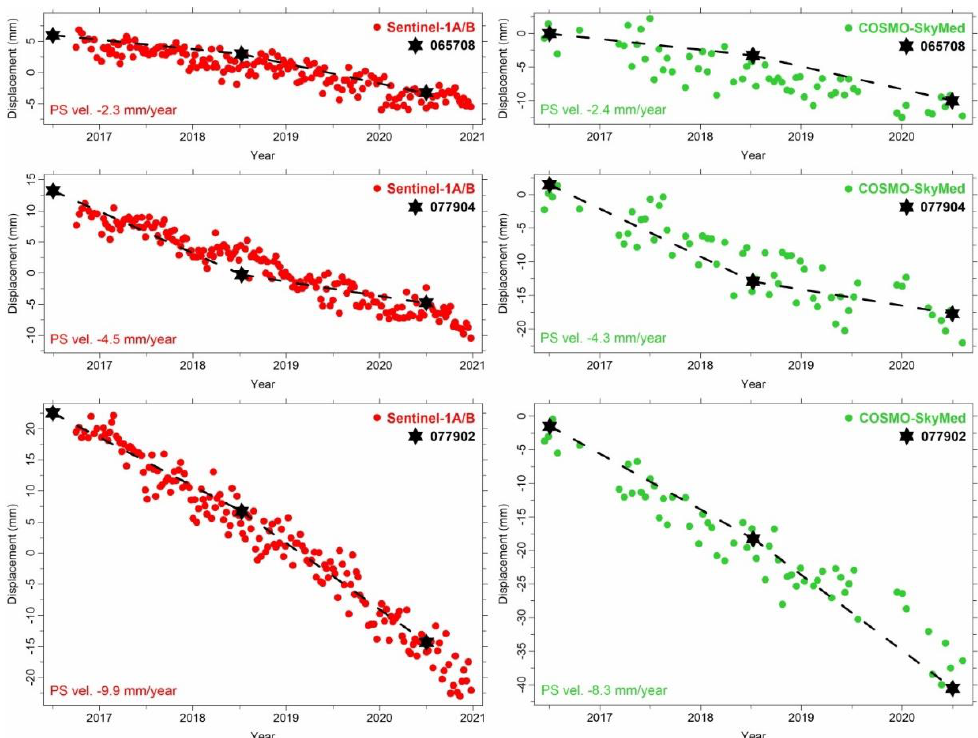
Figure 7. Comparison between the LOS displacements time series of three NPS GNSS sites characterized by different velocities (065708, 077904, and 077902, Figure 1, Table 3) and the closest Sentinel-1 ( left ) and the CSK ( right ) points.